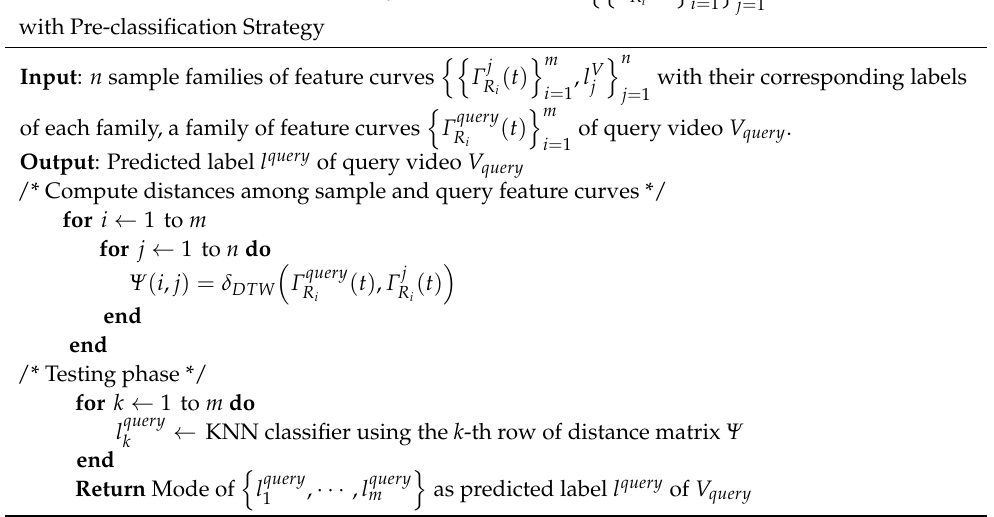
(cid:111) m (cid:111) n (cid:110)(cid:110) ( t ) Γ j on SPD Manifold R i i = 1 j = 1